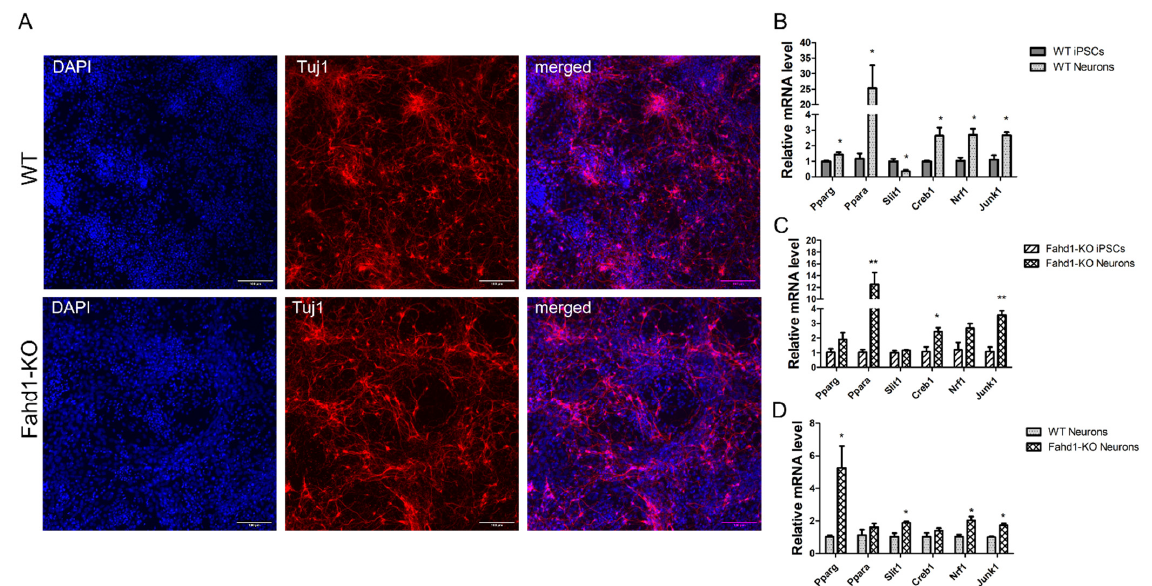
Figure 5. A high degree of mitochondrial biogenesis is maintained in Fahd1-KO iPSC-derived neurons. ( A ) Immunocytochemistry against the neuronal marker Tuj1 and the nuclei marker DAPI showed an efficient neuronal differentiation in both WT and Fahd1-KO iPSCs. ( B – D ) Relative mRNA expression of mt biogenesis markers, Pparg, Ppara, Slit1, Creb1, Nrf1, and Junk1. ( B ) Upregulation of mt biogenesis markers in iPSC-derived neurons relative to WT iPSCs. ( C ) Upregulation of mt biogenesis markers in Fahd1-KO iPSC-derived neurons relative to Fahd1-KO iPSCs. ( D ) Expression of mt biogenesis markers in neurons produced from Fahd1-KO and WT iPSCs. All the analyses were performed on iPSC-derived neurons after 20 days of differentiation, p < 0.05, ** p < 0.01, n = 3. iPSCs: induced pluripotent stem cells, WT: wild type, KO: knock-out.